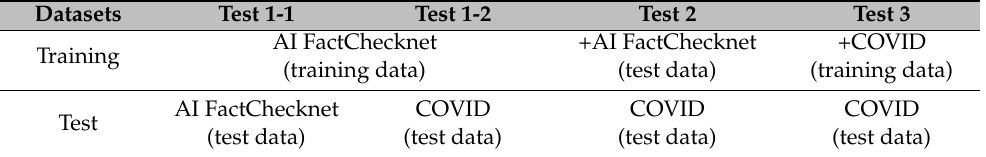
Table 3. Dataset configurations for transfer